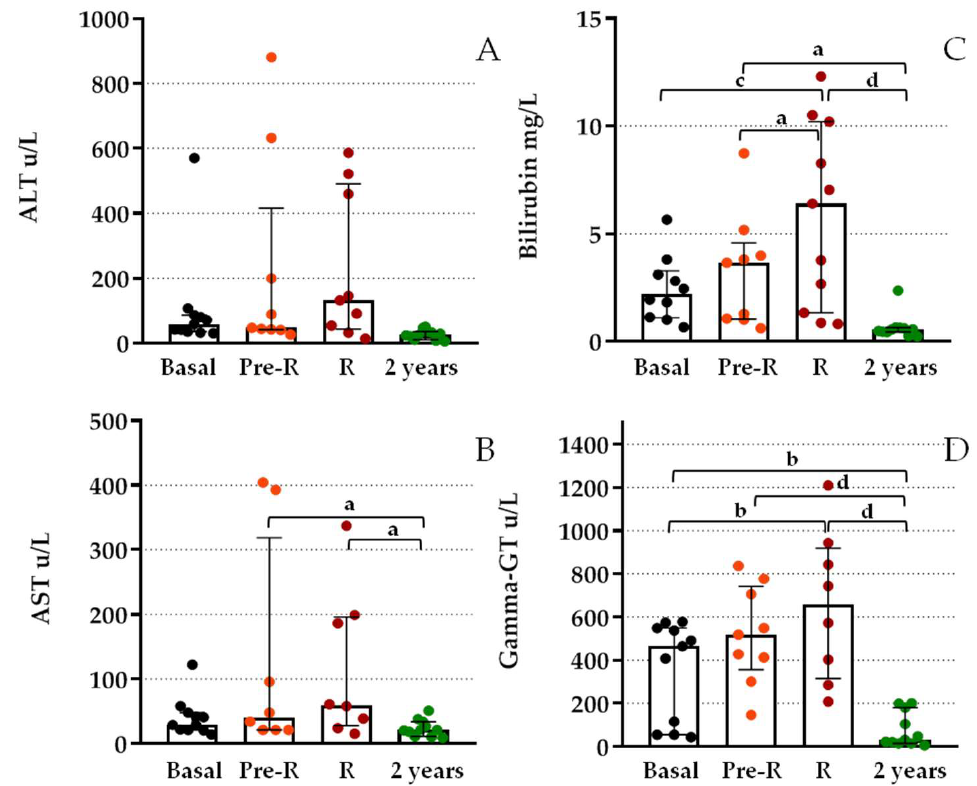
Figure 4. Differences in functional liver marker levels at BPR and previous to BPR from patients after TX. ( A ) Serum alanine aminotransferase (ALT); ( B ) aspartate aminotransferase (AST); ( C ) bilirubin; and ( D ) gamma-glutamyltransferase (gamma-GT) levels of patients after TX at BPR (R), 2–3 days before BPR (pre-R) compared to basal levels and 2 years after TX. Boxes represent median and inter-quartile ranges and whiskers show 5th–95th percentile. ANOVA test p < 0.0001. Analysis between groups by post hoc Bonferroni test; (a) p < 0.05; (b) p < 0.01; (c) p = 0.005; (d) p < 0.0001.